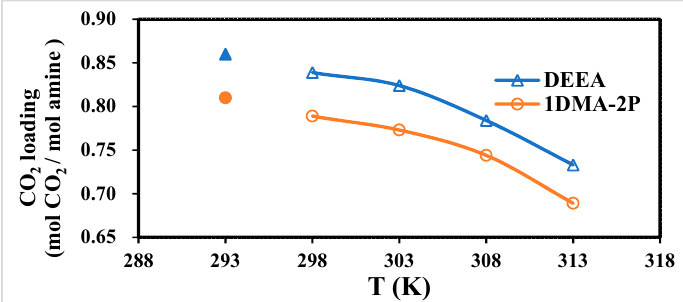
Figure 1. The critical point of CO 2 absorption curves at 1 atm and 293 K, and CO 2 equilibrium solubility of DEEA and 1DMA-2P at pressure of 1 atm and 298–313 K [5].